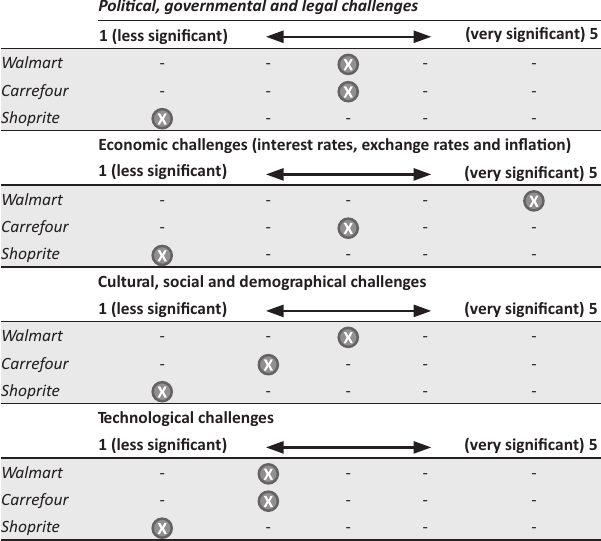
FIGURE 4: External factor assessments for Walmart, Carrefour and